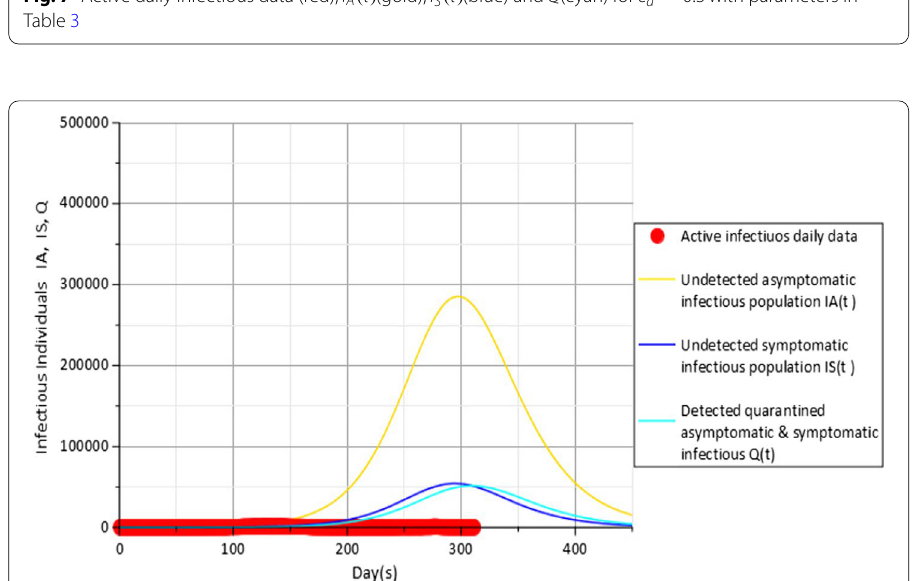
asymptomatic infectious population I A (gold), 79,844 undetected symptomatic infec- tious population I S (blue) and 73,602 detected quarantined asymptomatic and symp- tomatic population Q ( t ) (cyan) at the peak of the COVID-19 incidence. However, a further increase of about 5% in observing social distancing within the population causes a further reduction in the COVID-19 incidence rate to about 350,451 unde- tected asymptomatic infectious population I A (gold), 67,174 undetected symptomatic infectious population I S (blue) and 62,780 detected quarantined asymptomatic and symptomatic population Q ( t ) (cyan) as indicated in Fig.